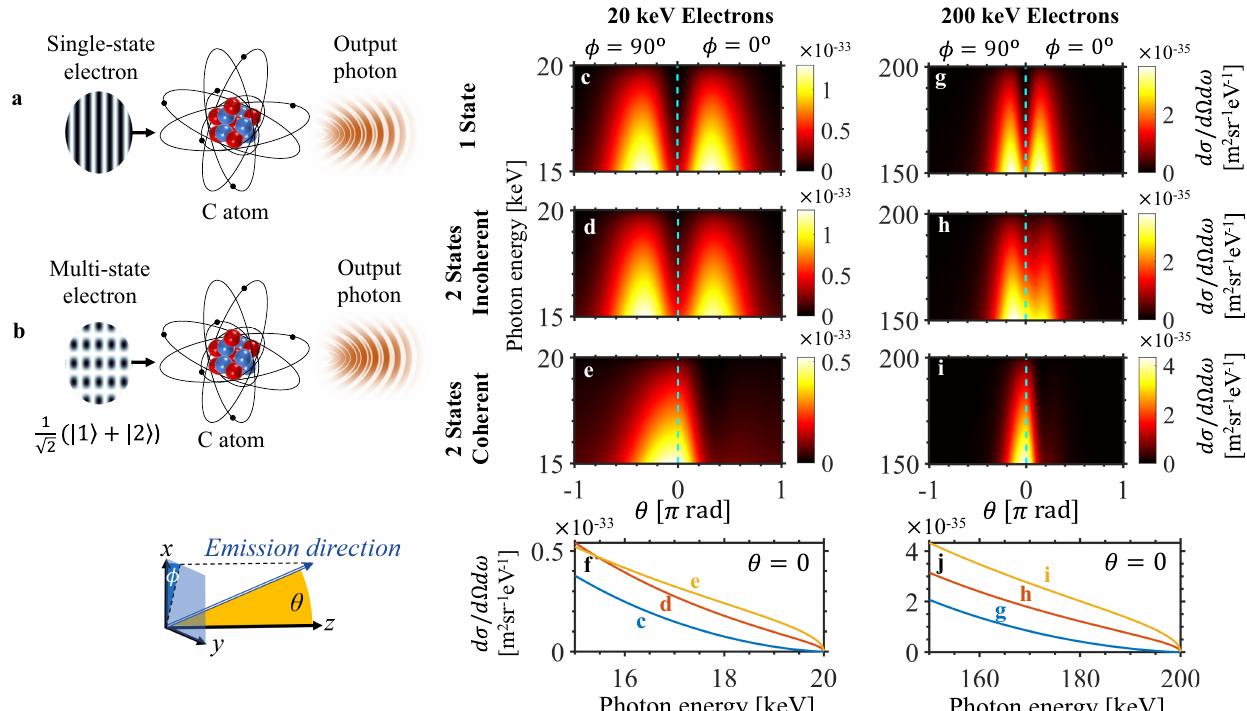
Fig. 2 Enhanced directionality in atomic bremsstrahlung through shaped electron wavepackets. In the typical atomic bremsstrahlung scenario a , a single momentum state electron scatters off a carbon atom and emits radiation. Shaping the input electron wavepacket through the use of multiple states as in b , where the input is a superposition of states 1 j i and 2 j i , can enhance the output photon properties through coherent interference between the processes associated with each individual electron state. To illustrate this, c – e show the differential cross section d σ = d Ω d ω of the emission process for 20 keV electrons, with a single z -directed input electron state in c , and two input electron states of opposite phase and oriented at θ 1 ; 2 ¼ ± 15 o with respect to the z -axis in d and e . A donut-shaped emission pattern, as indicated by the off-axis peaks, is expected for the single-state c and incoherent double-state d cases. In contrast, quantum interference between the constituent processes in e strongly suppresses off-axis emission, resulting in an emission pattern that is more directional and peaked on-axis. Cross-section emission patterns at θ = 0 are compared in ( f ). The enhanced directionality also holds at other choices of electron energies and angles, as shown in g – j , which presents the emission spectra corresponding to the scenarios in c – f , respectively, but for 200 keV electrons, at θ 1 ; 2 ¼ ± 15 o